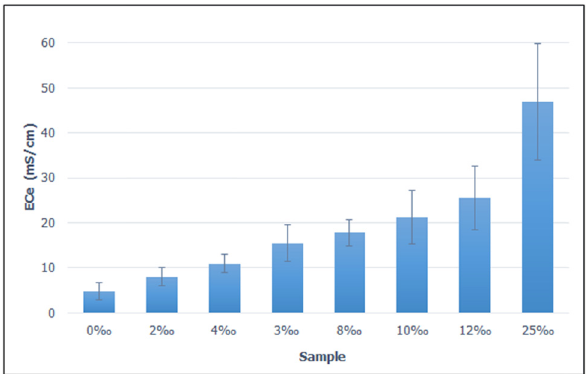
Figure 1: E ff ect of saltwater salinity on EC of the saturated paste extracts ( ECe ) after 12 weeks of salinity treatment.